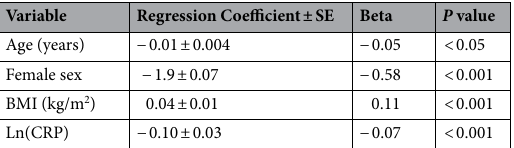
Table 5. Association between hsCRP and haemoglobin levels. hsCRP was associated with haemoglobin levels, independently of age, sex, and BMI.